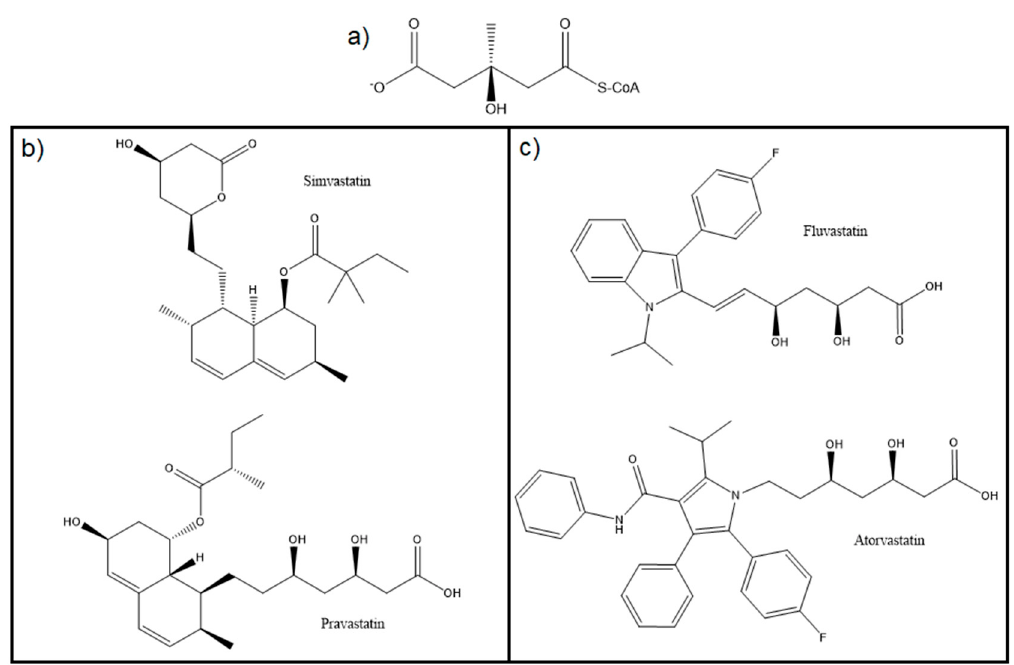
Figure 12. Structures of: ( a ) HMG-CoA; ( b ) Type I statins; and ( c ) Type II statins.